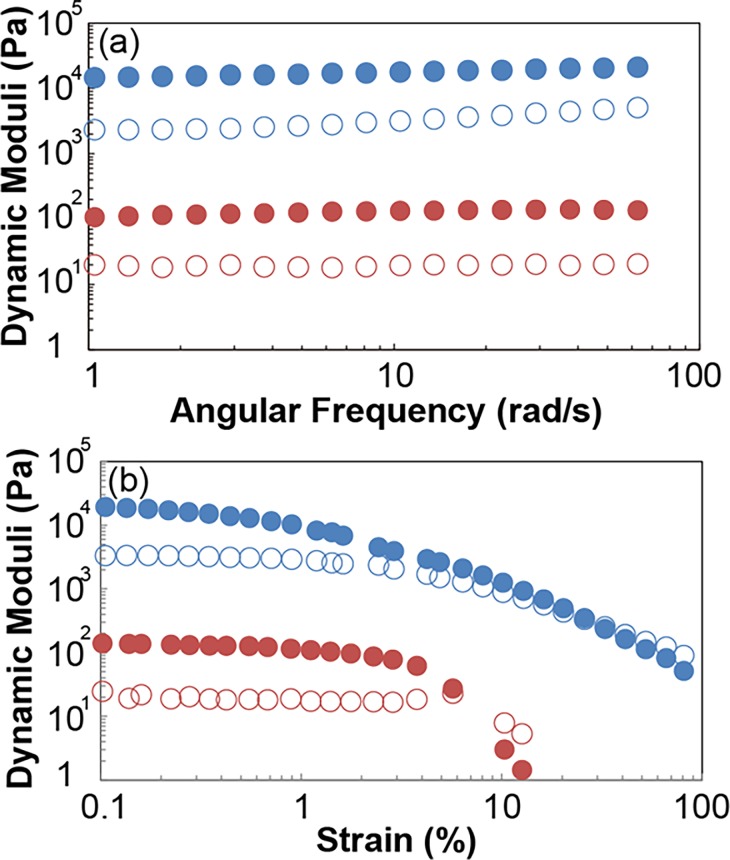
(a) Frequency-dependence of G’ (filled circle) and G” (blanked circle) for ATBAG (blue) and ATBAS (red). (b) Strain-dependence of G’ (filled square) and G” (blanked square) for ATBAG (blue) and ATBAS (red).